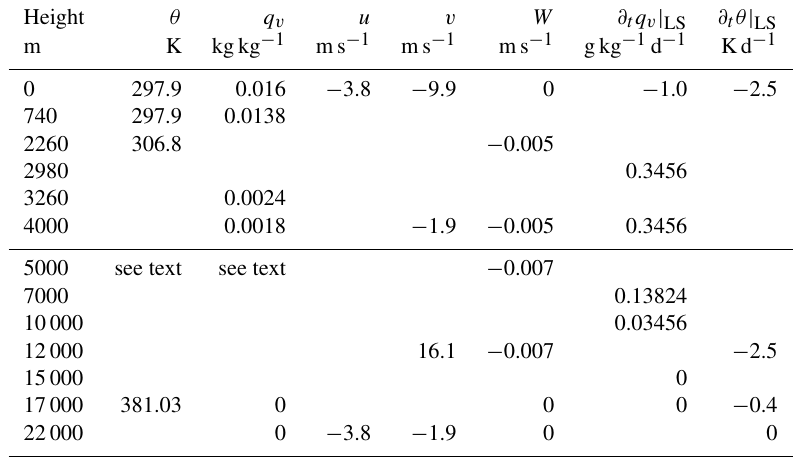
Table A1. Fixed points for piecewise linear profiles of θ , q v , u , v , the subsidence rate W and the large-scale forcing of heat ∂ t θ | LS